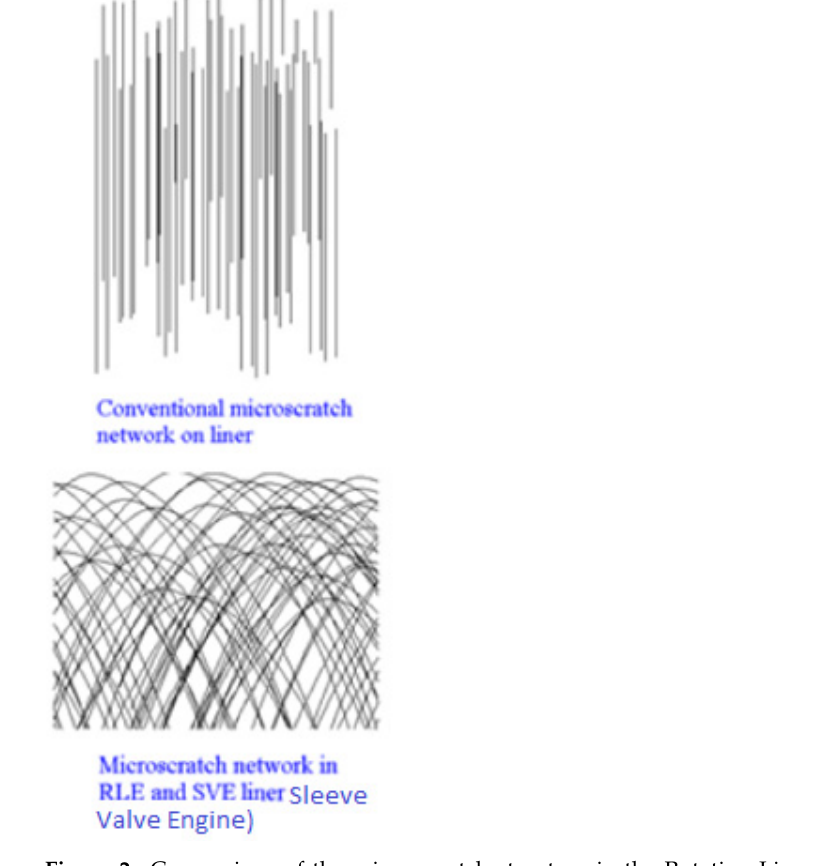
Figure 2. Comparison of the micro-scratch structure in the Rotating Liner Engine (RLE) and a conventional engine on the cylinder liner close to the piston ring